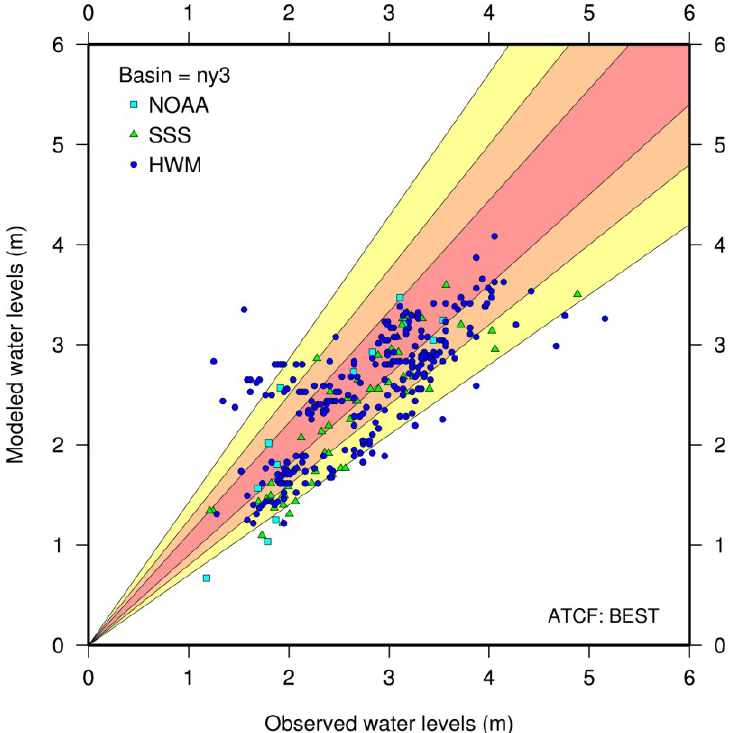
Figure 19. Comparison of water levels (m) at all NOAA tidal gauges, USGS storm surge sensors (SSS) and High Water Marks (HWM) vs. SLOSH model-simulated maximum water levels (m). Water surface elevation errors at most locations are within the 10%–20% range (dark orange